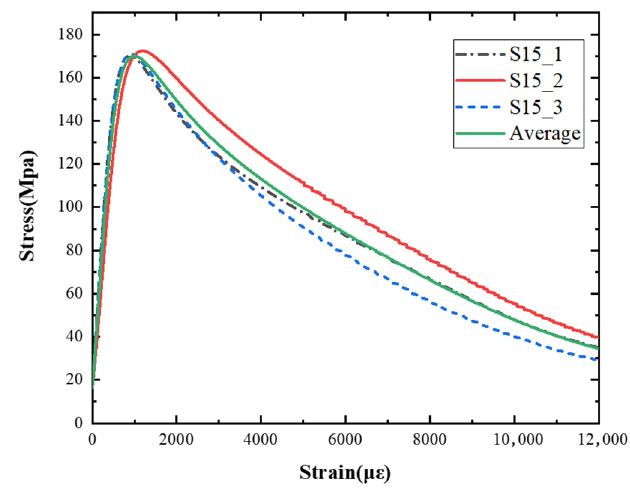
Figure 7. Stress–strain curve of 15 m/s.